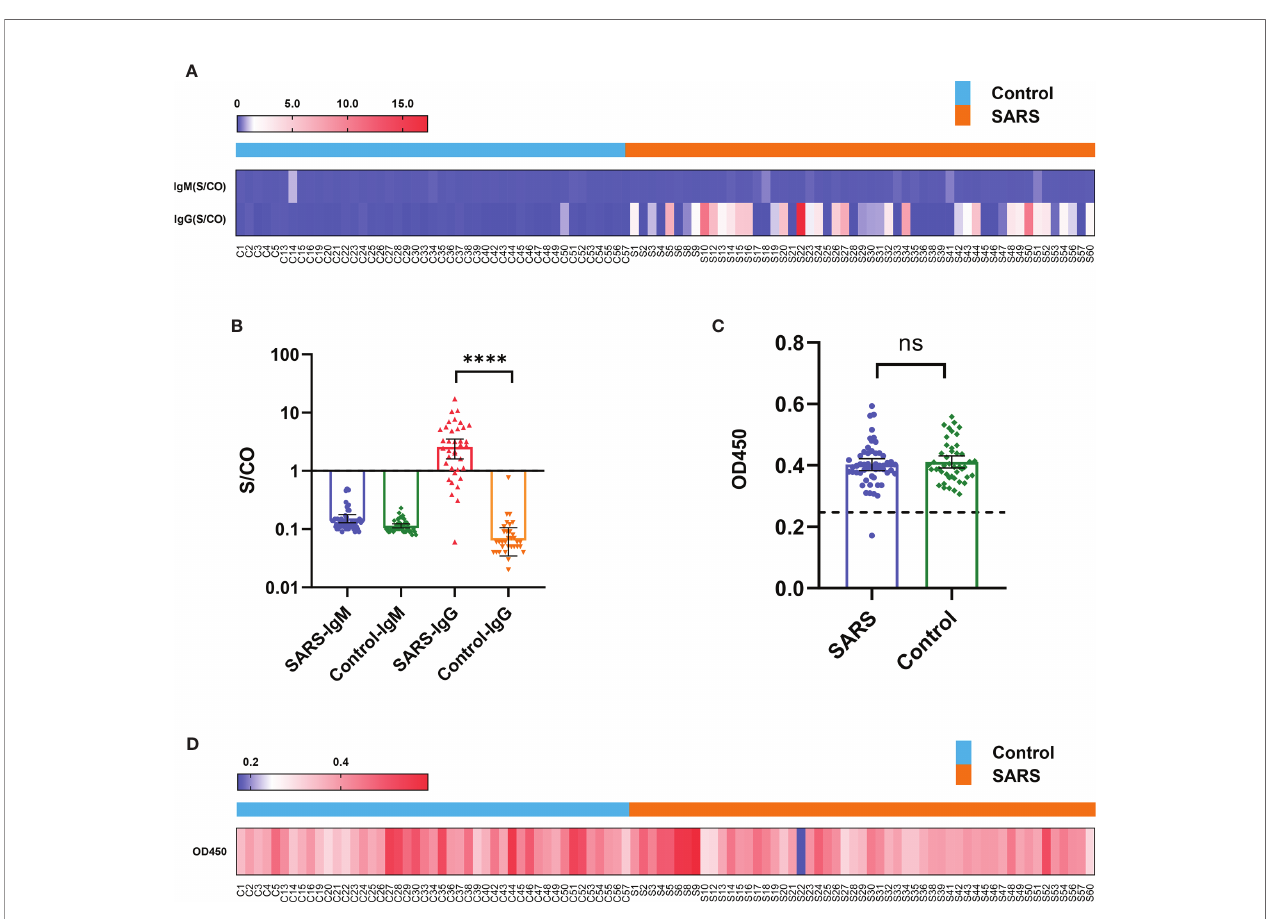
FIGURE 1 | Immune cross-reactivity of convalescent patient serums with SARS collected from 15 years post-infection against the SARS-CoV-2 spike protein. (A) Heatmap of antibody titres. (B) Histogram of antibody titres expressed in terms of mean and 95% con fi dence interval (CI). (C) Histogram of OD450 in the ACE2 competition assay in terms of mean and 95% CI. (D) Heatmap of OD450 in the ACE2 competition assay. ****P < 0.0001. ns, no signi fi cant